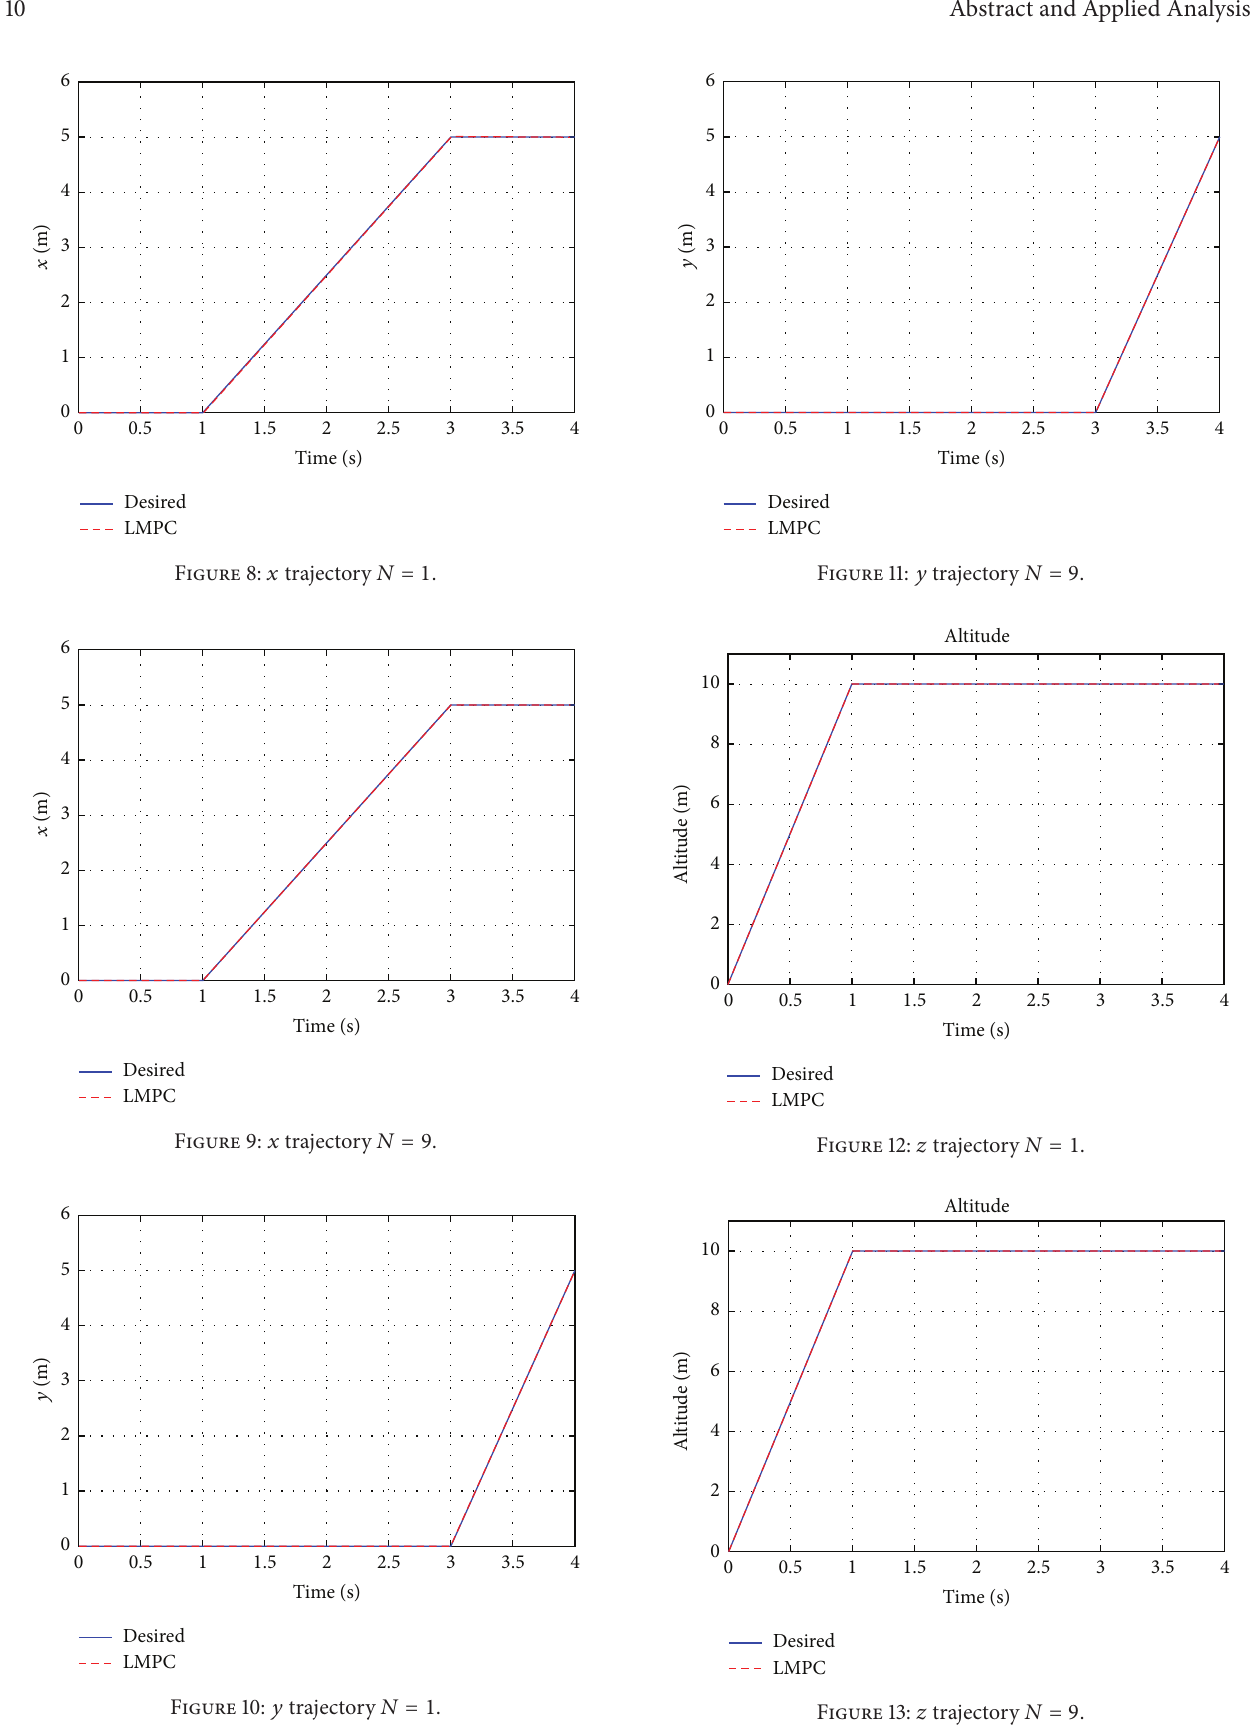
Figure 13: 𝑧 trajectory 𝑁 = 9